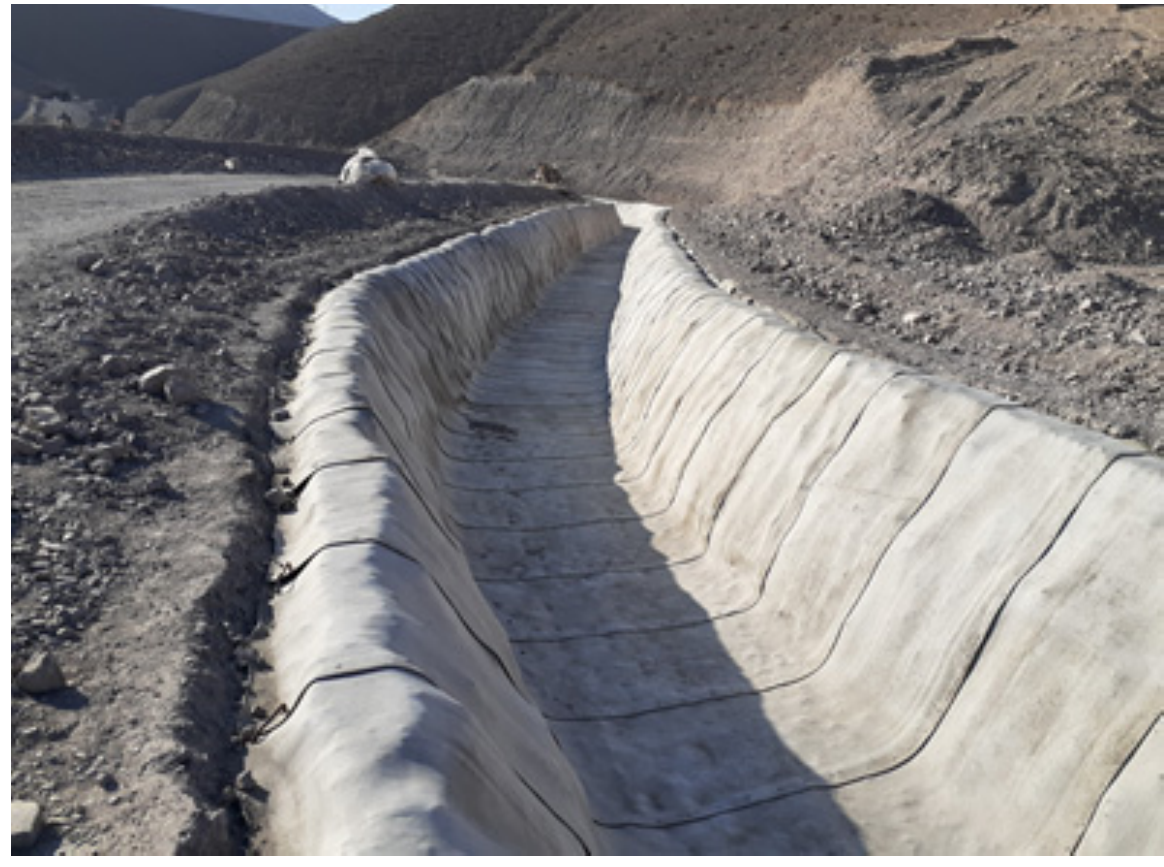
Figure 18. Collection and diversion system for non-contact water–perimeter ditches [27].